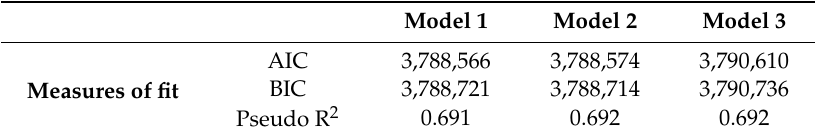
Table 2. LR models fit